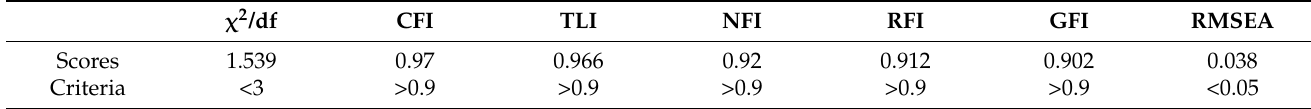
Table 4. Overall fit indices of the measurement model.